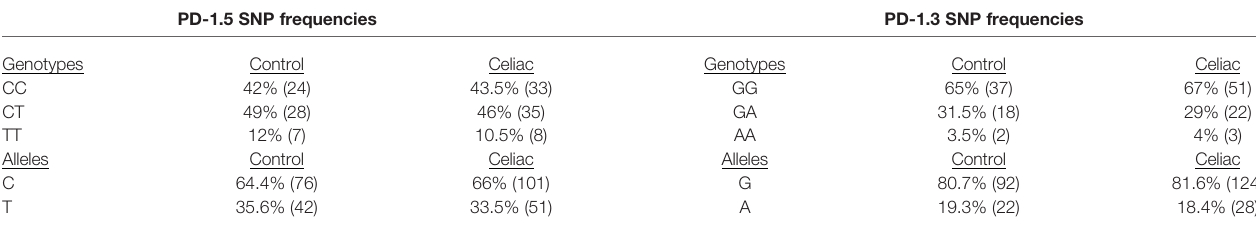
TABLE 3 | Allele and genotype frequencies of polymorphic sites of the PD1 gene in celiac Spanish population. PD-1.5 SNP